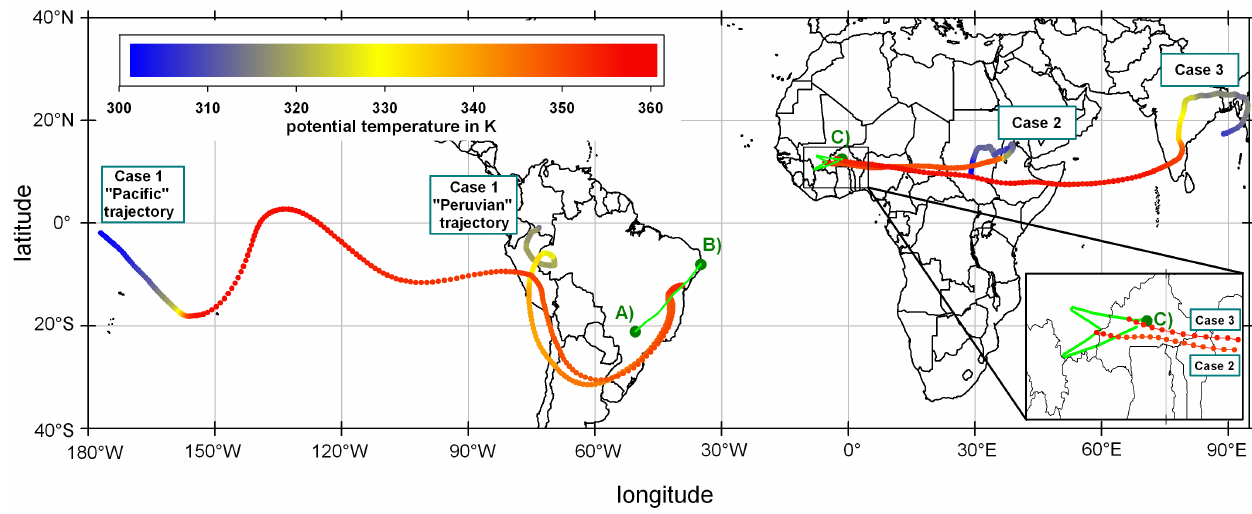
Fig. 6. Air mass trajectories for the NPF Cases 1–3 from different source regions intersecting the M-55 Geophysica flight tracks (light green) between (A) Arac¸atuba and (B) Recife, Brazil (Case 1, TROCCINOX) and during a local flight with departure and destination at (C) Ouagadougou, Burkina Faso (Case 2 and 3, SCOUT-AMMA) determined from FLEXTRA simulations. Trajectories are colored according to the potential temperature evolution along their pathways indicating vertical air mass movement. A close-up (bottom right) illustrates where the trajectories intersect with the SCOUT-AMMA flight track on 7 August